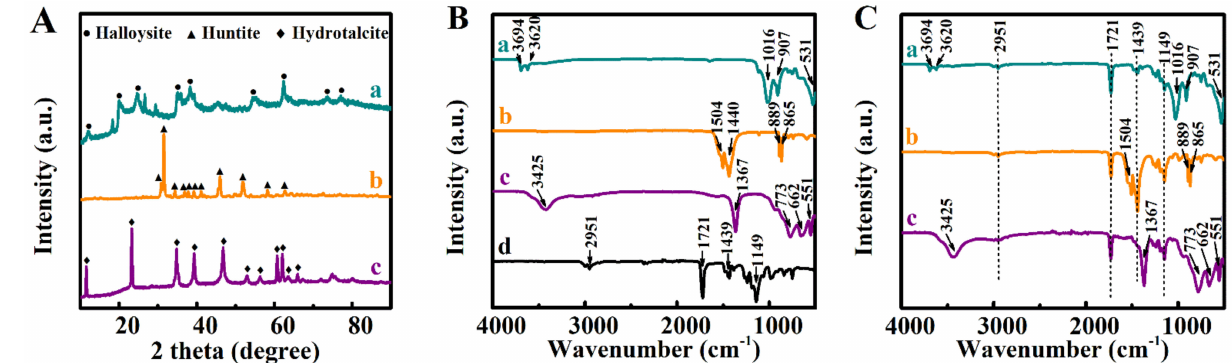
Figure 5. ( A ) X-ray diffraction patterns of the deposits obtained from 10 g L − 1 solutions of PMMA with R wip = 0.25, containing 10 g L − 1 FRM additives: ( a ) halloysite, ( b ) huntite, and ( c ) hydrotalcite, ( B , C ) FTIR spectra of ( B ) as-received materials: ( a ) halloysite, ( b ) huntite ( c ) hydrotalcite, and ( d ) PMMA; ( C ) coating prepared from 10 g L − 1 solutions of PMMA with R wip = 0.25, containing 10 g L − 1 FRM additives: ( a ) halloysite, ( b ) huntite, ( c )